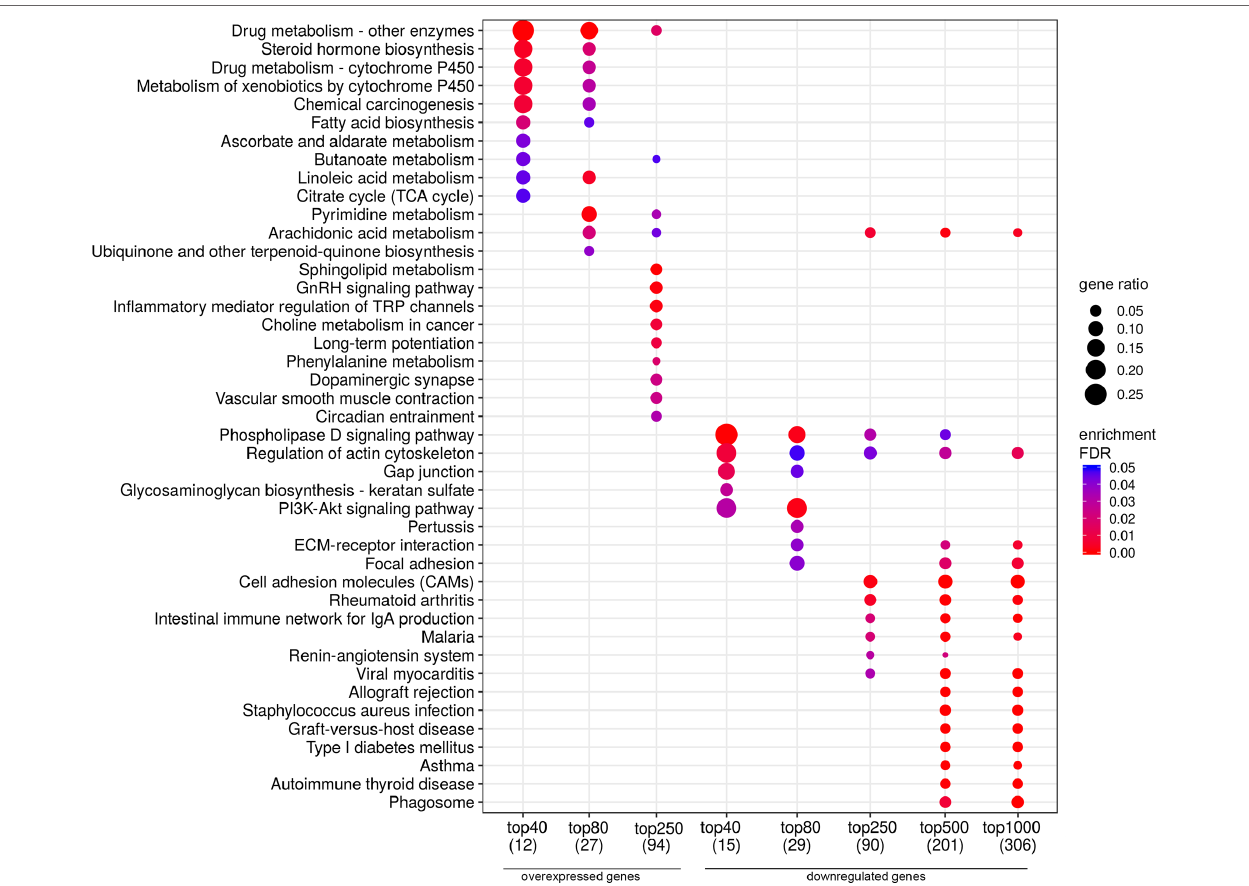
FIGURE 8 | Dotplot showing the results of KEGG pathways enrichment analyses performed for top-40, 80, 250, 500, and 1,000 differentially expressed genes (either overexpressed or downregulated) between the groups of adverse and favorable prognosis (Russian patient cohort). All the genes have passed the following thresholds: DESeq p -value < 0.01, Mann–Whitney p -value < 0.05, average expression-level fold change > 25%. Dot size indicates k / n ratio (“gene ratio”), where k is the number of genes participating in the current KEGG pathway (within top-40, top-80 or other top lists), and n is the number of genes (also within top-40, top-80, or other top lists) annotated as participants of any KEGG pathway (these numbers are provided in the brackets in the bottom of the figure). Dot color indicates the enrichment test FDR (Fisher’s exact test).